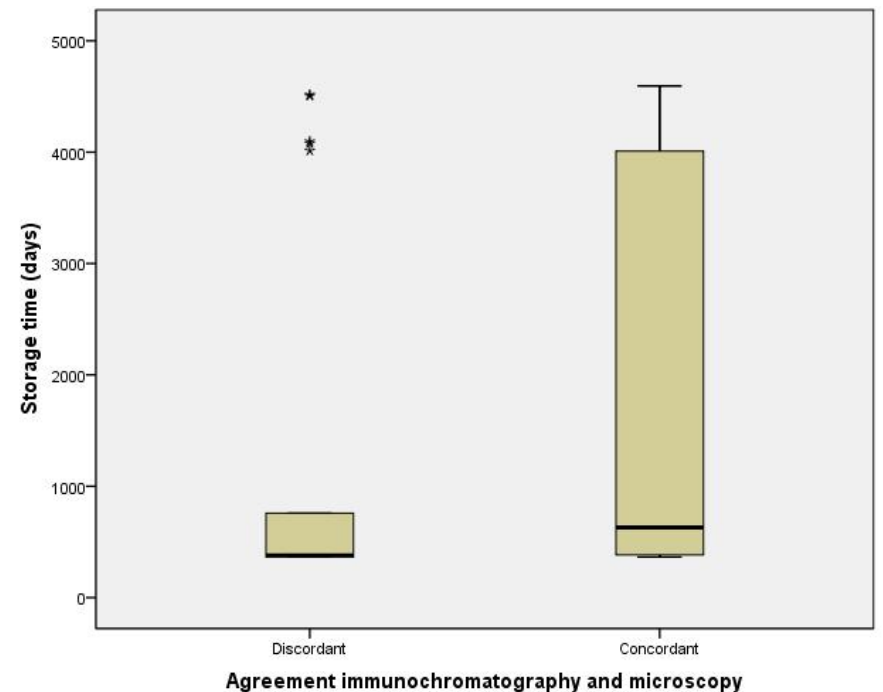
Figure 1 - Distribution of concordant results between microscopy and immunochromatography according to frozen storage time.